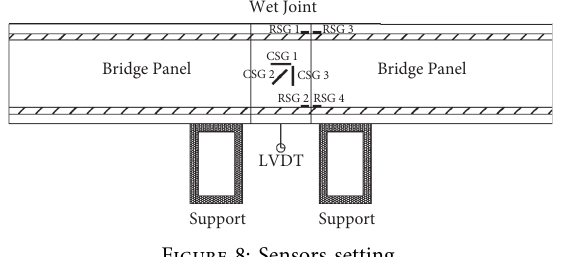
Figure 7: Loading process.